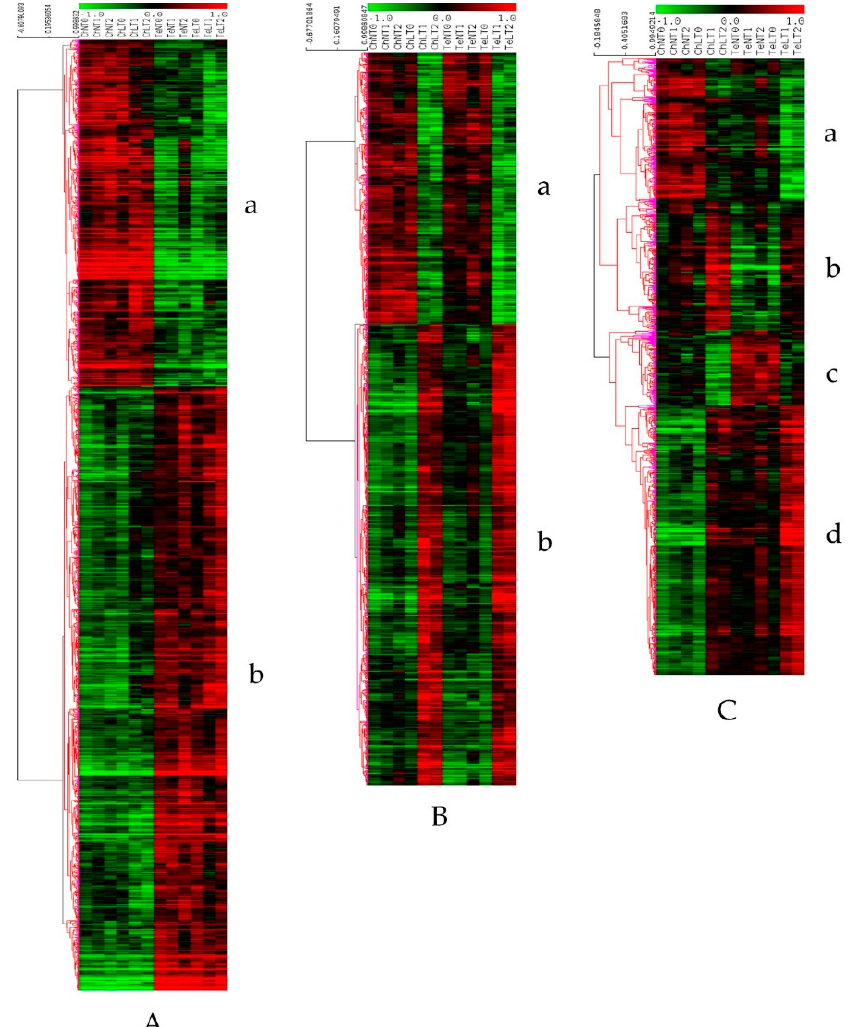
Figure 3. Hierarchical clustering of the three sets of di ff erentially expressed genes. ( A ): “Line Response” containing two subsets, a (Ch up) and b (Te up); ( B ): “Temperature Common Response” having two subsets, a (TCR down) and b (TCR up) and (C): “Temperature Line Specific Response” including four subsets, TLSR a, b, c, and d. The order of the columns from left to right are ChNT0, ChNT1, ChNT2, ChLT0, ChLT1, ChLT2, TeNT0, TeNT1, TeNT2, TeLT0, TeLT1, and TeLT2.